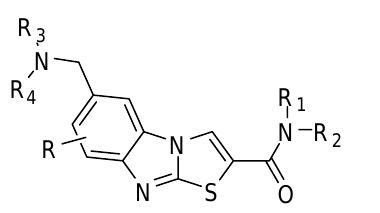
Figure 5. 6-Aminomethyl-substituted thiazolobenzimidazole